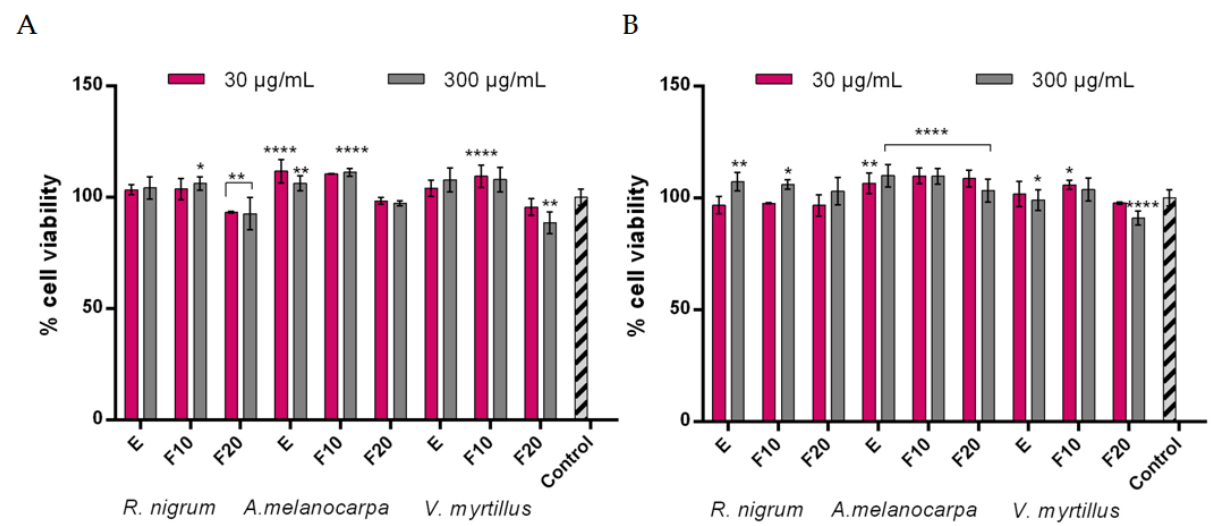
Figure 5. Effect of R. nigrum, A. melanocarpa , and V. myrtillus extracts and ferments (at the concen- tration of 30 and 300 µg/mL) on Alamar Blue assay ( A ) and neutral red dye uptake ( B ) in cultured fibroblasts (BJ) after 24 h of exposure. Data are the mean ± SD of three independent experiments, each consisting of three replicates per test group; **** p < 0.0001, *** p < 0.001, ** p < 0.01, and * p < 0.05 compared to the control.